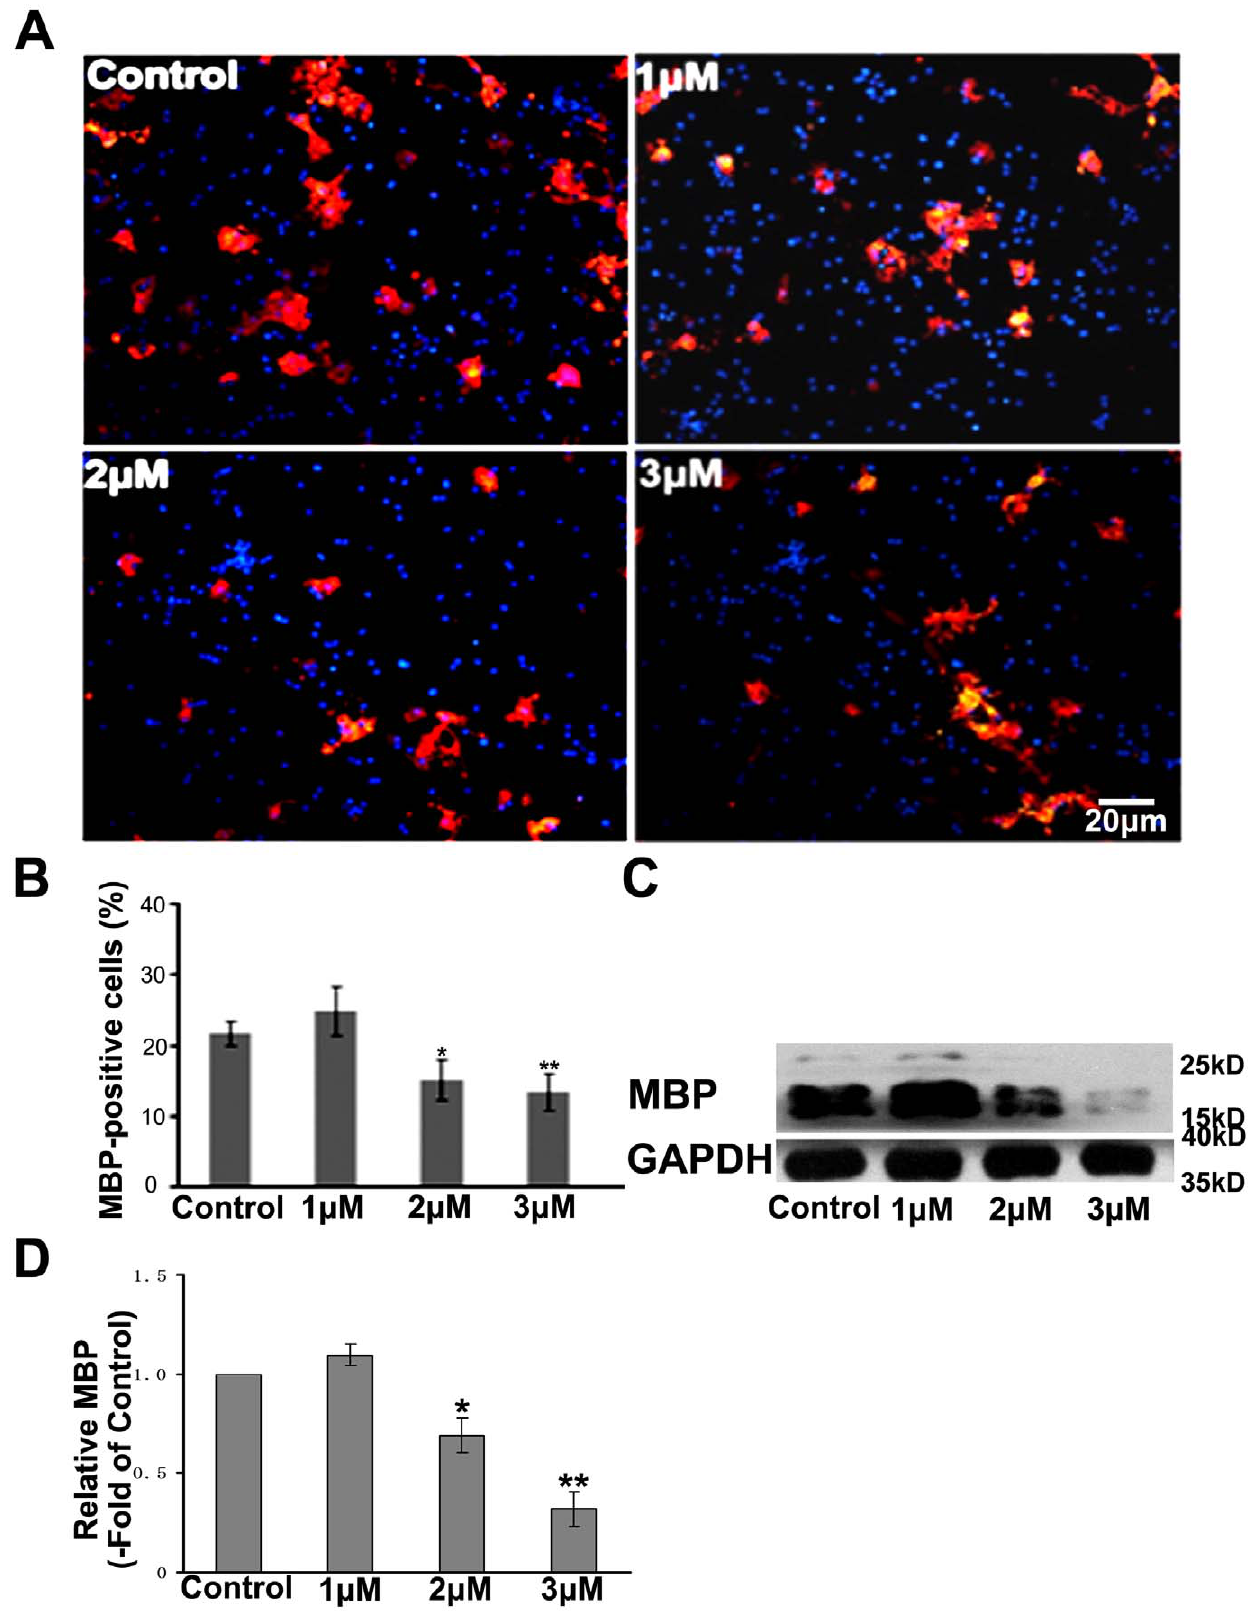
Figure 4. PTPi IV attenuates MBP expression of oligodendrocytes in vitro. ( A ) OPCs were pre-treated with different doses of PTPi IV for 6 h every 24 h before the medium were changed to fresh differentiation medium without PTPi IV. OPCs were immunostained with anti-MBP antibody (red) 3 days after induction of maturation. The total number of cells was identified by Hoechst staining (blue). The culture added DMSO was used as